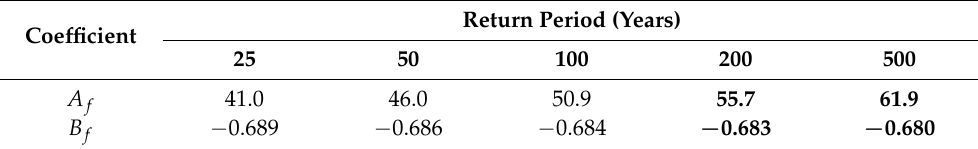
Table 1. Coefficient values of the IDF curve estimated by ECCC (regular font) and extrapolated (bold).